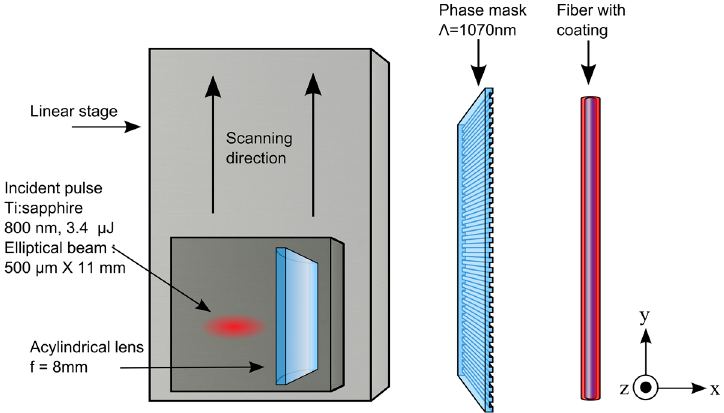
Figure 1. Fiber Bragg grating (FBG) writing set-up for an elliptical reshaped beam. Some results reported in this paper were obtained with a Gaussian beam (d ~ 11 mm) written on the same writing set-up.